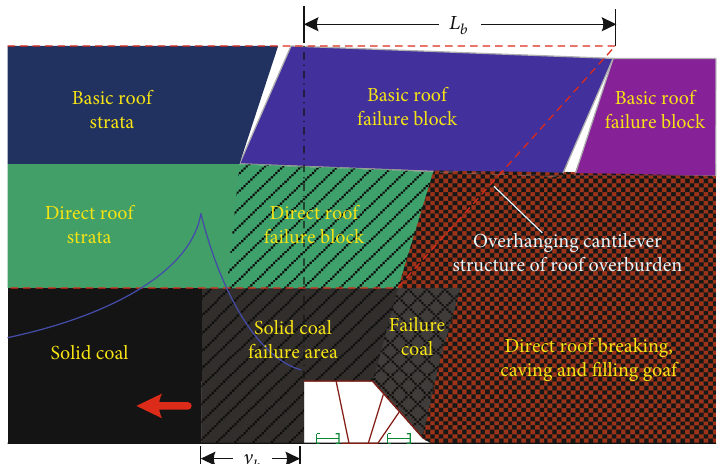
Figure 8: Cantilever structure characteristics of the coal wall roof in the isolated island face in fully mechanized top-coal caving